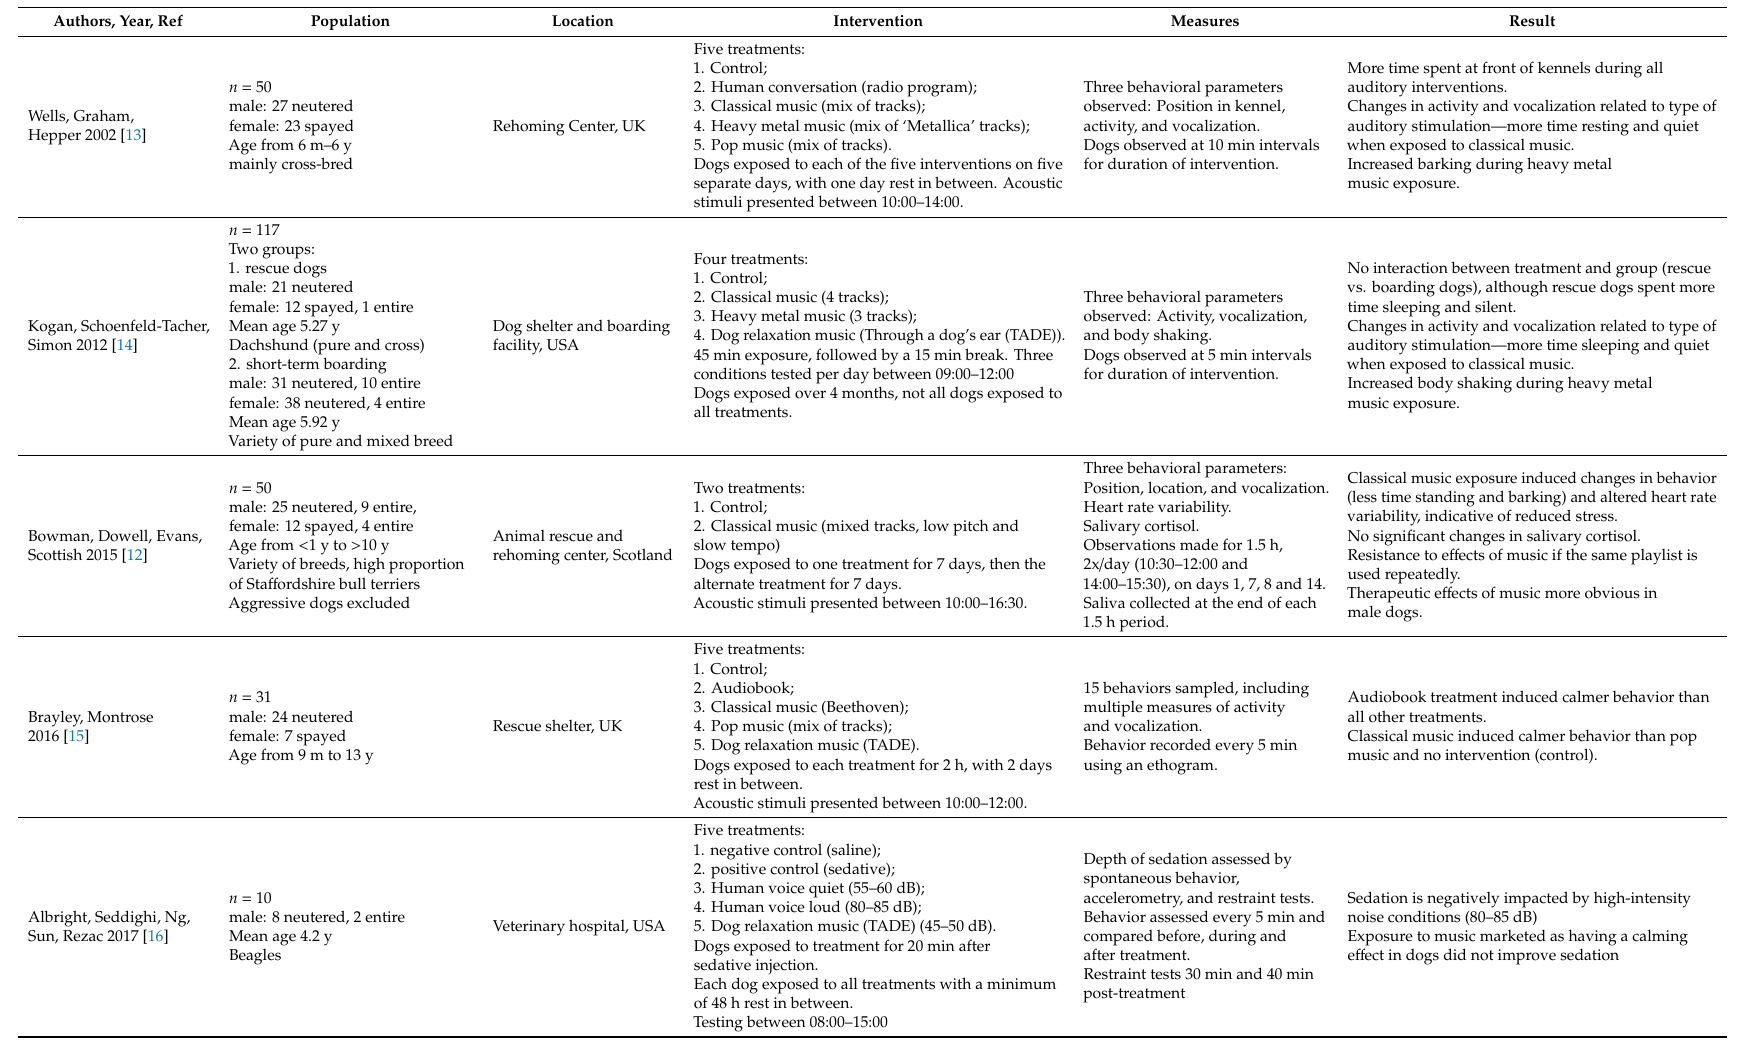
Table 1. Studies examining e ff ects of auditory enrichment on canine health and